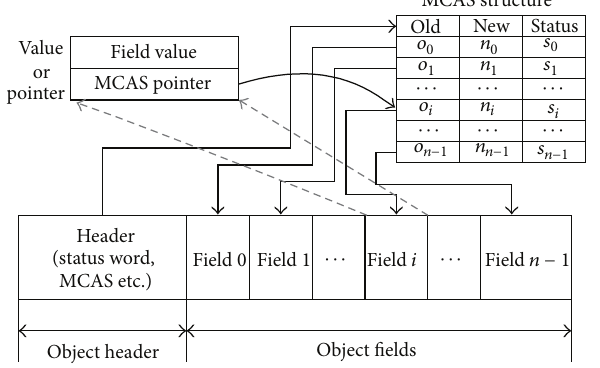
Figure 3: Layout of MCAS-based extended object model.